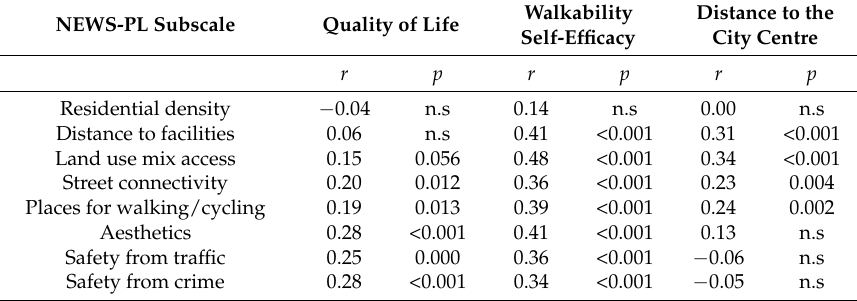
Table 3. Correlation matrix between NEWS-PL subscales, quality of life, self-efficacy, proximity to the city centre (N =